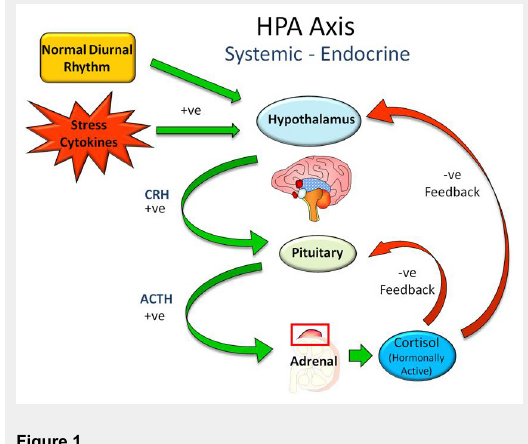
Systemic regulation of circulating cortisol levels by the hypothalamic pituitary adrenal (HPA) axis. Signalling to the hypothalamus by the normal circadian rhythm, stress, and pro- inflammatory cytokines increase release of corticotropin releasing hormone (CRH) from the hypothalamus. This acts on the pituitary to increase release of adrenocorticotropic hormone (ACTH) that acts to increase cortisol synthesis and secretion from the adrenal gland. Cortisol suppresses both CRF and ACTH at the pituitary and hypothalamus and a negative feedback